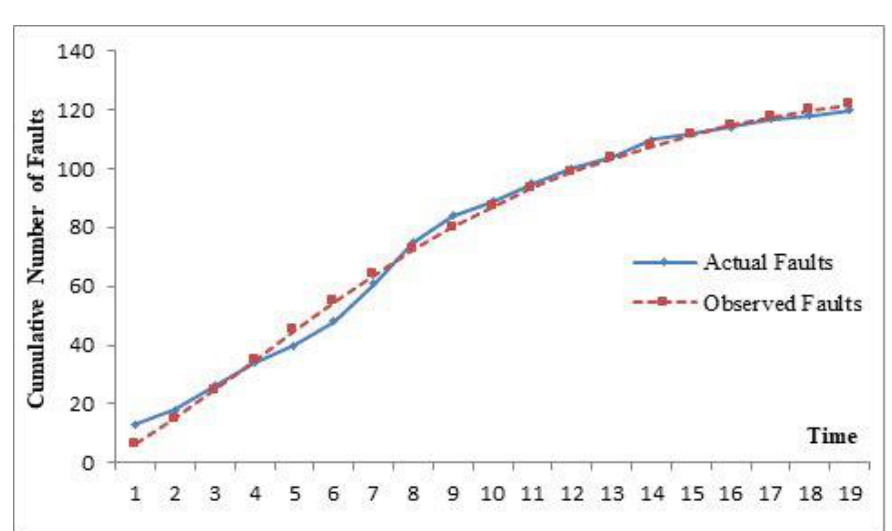
Fig. 2. Goodness of fit curve for Release